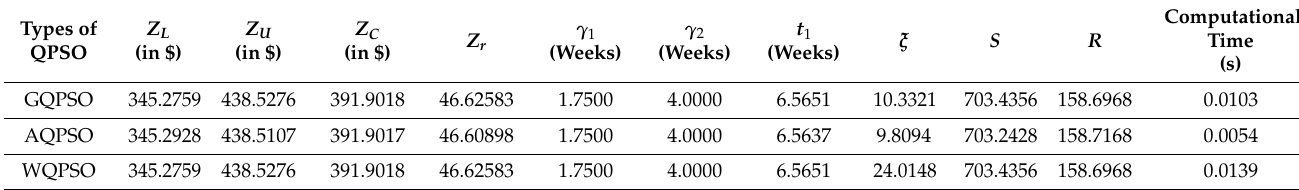
Table 8. Best found results for Case-III of Example 3.